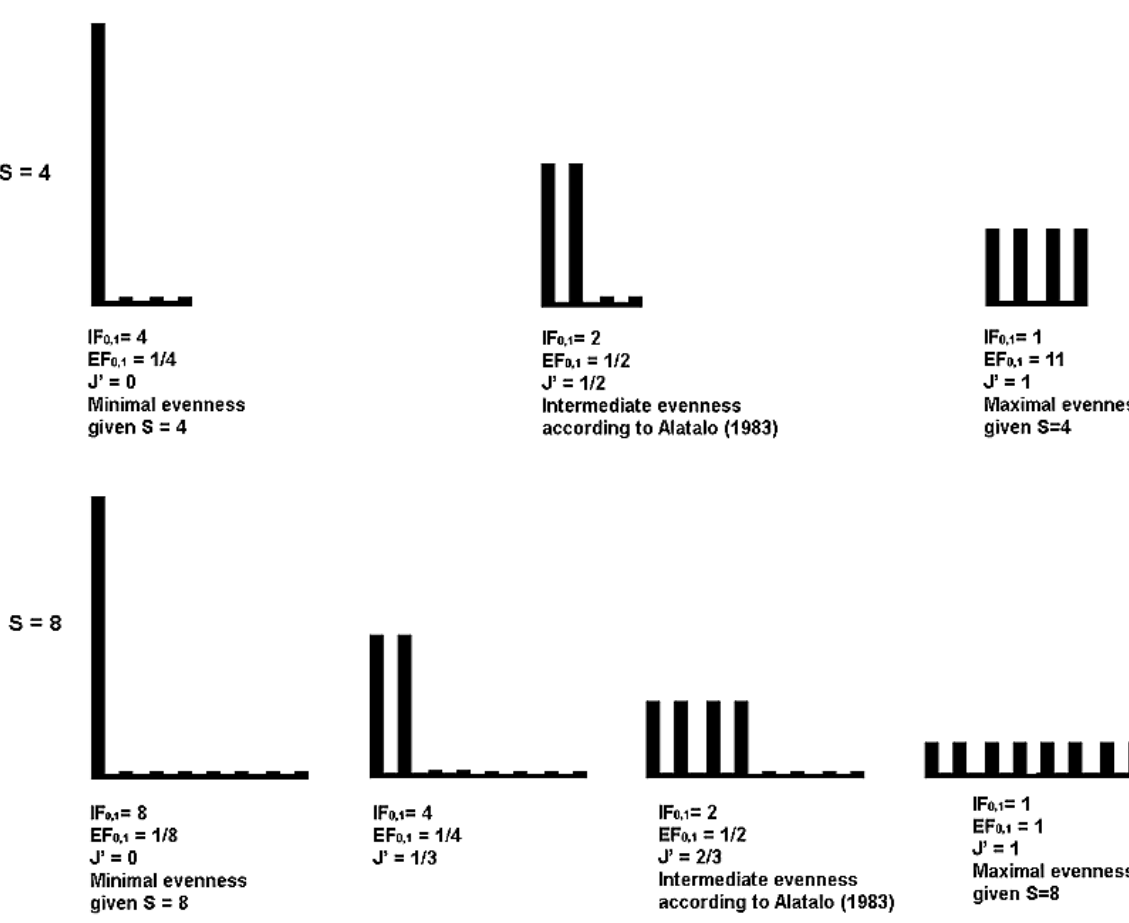
Figure 7. Changes in evenness and inequality in equal steps . Each step involves transfer of half the abundance of the community. When richness S is high, Alatalo’s [26] intermediate communities are closer to the perfectly even community than to the center. This explains why J seems to vary with richness in his